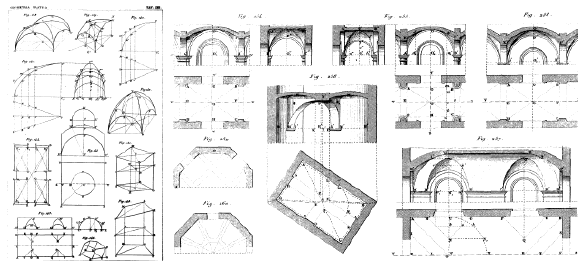
Figure 3. “A fascioni” vaults on a rectangular plan, geometric scheme (left) and architectural representation in orthographic projections (right). Sources: Curioni, 1868, Plate XIII; Curioni, 1865, Plate XXV